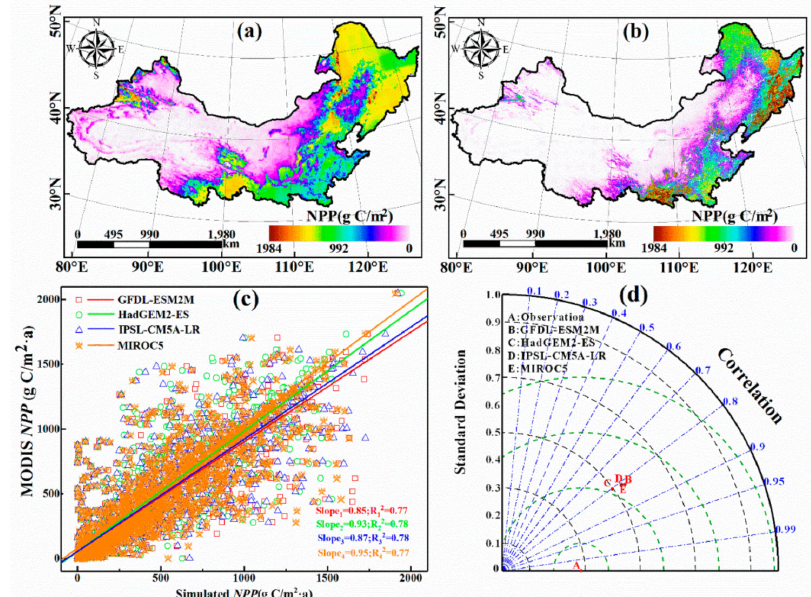
Figure 3. Simulation and validation of the CASA model; ( a ) represents the CASA simulation of the multi-annual change in mean net primary productivity (NPP); ( b ) represents a multi-annual NPP variation chart based on MODIS data (http: // luna.ntsg.umt.edu / data); ( c ) is based on the CASA model simulation of di ff erent climate models of the correlation between the model data and MODIS data; and ( d ) is the Taylor diagram between the field monitoring data and the simulated data based on the flux observation site from CASA